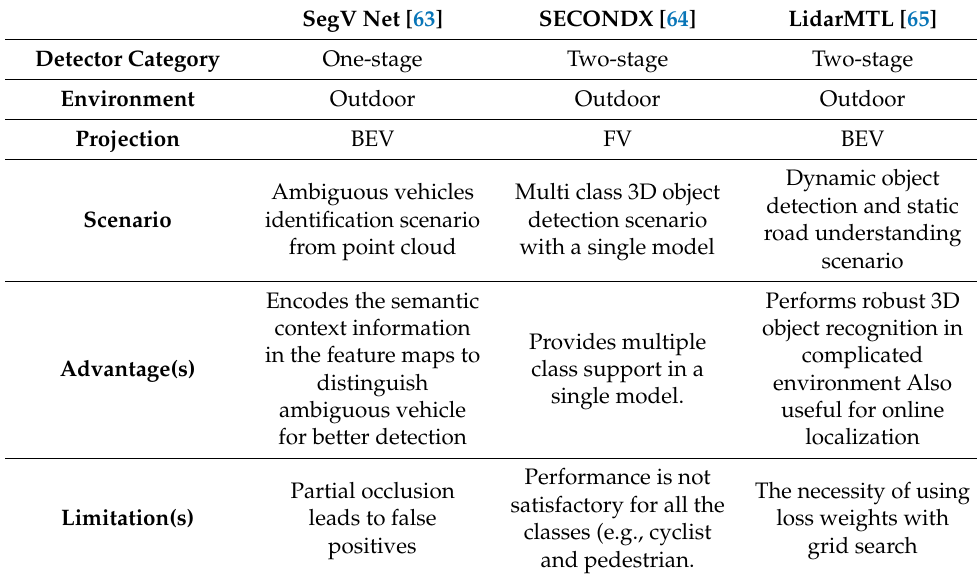
Figure 14. The network [65] is based on a UNet backbone with 3D sparse convolution and deconvolution to perform object detection on the Lidar BEV. Table 13. Literature Analysis: 3D Voxel Grid-based 3D Object Recognition